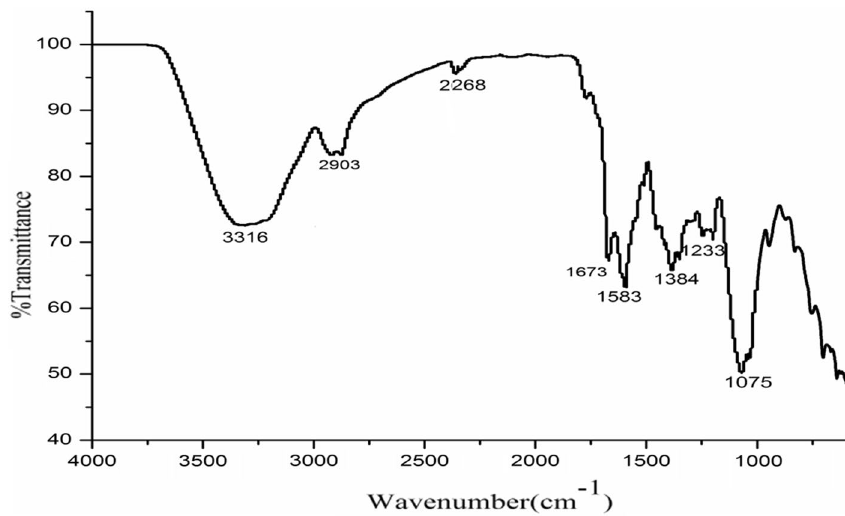
Fig. 2 Fourier-transform infra- red spectroscopy analyses of pharmaceutical